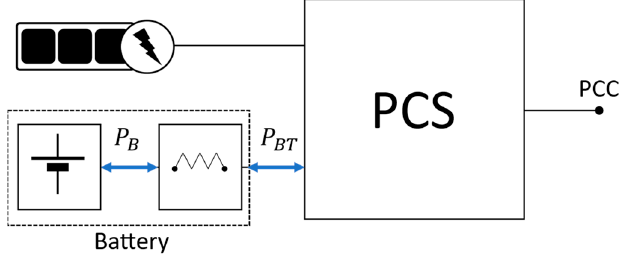
Figure A1. Power flow that involves the battery considering the round trip conversion